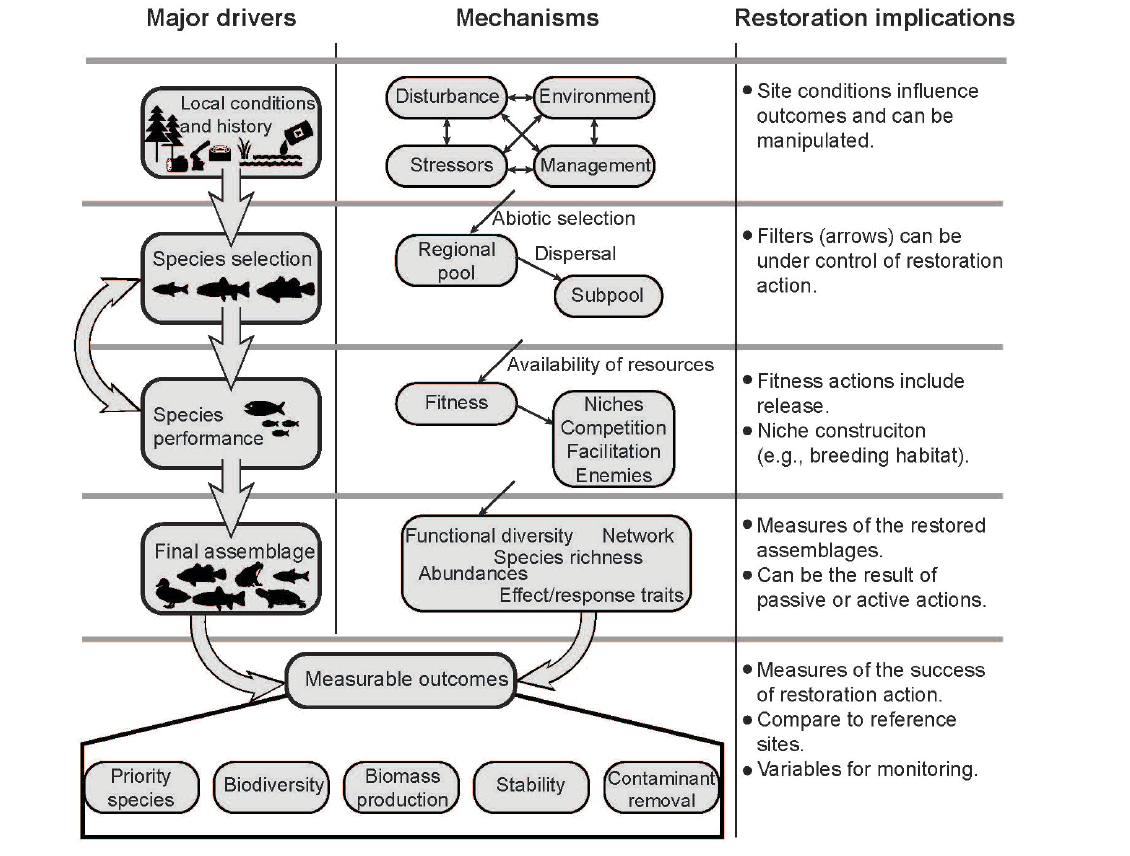
Fig. 4 . Restored habitats are subject to ecological assembly mechanisms. These mechanisms control which species can colonize, and their performance, the outcomes of species interactions, and the resulting diversity of the assemblage. Boxes in bold indicate assembly processes that can be manipulated by restoration